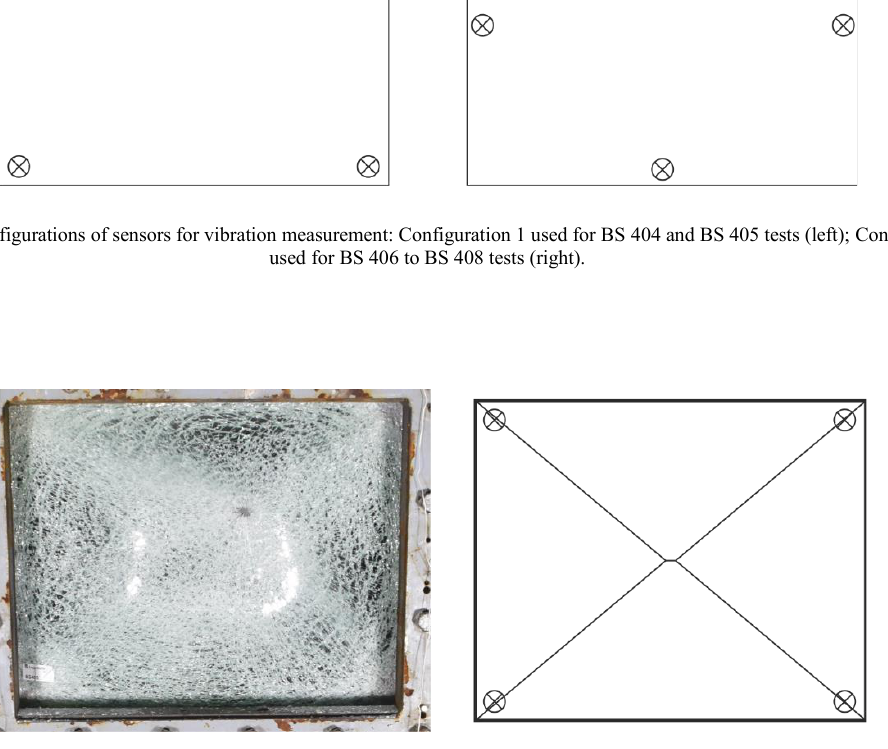
Fig. 3 Fracture pattern of glass pane 1 in BS 405 test (left); position sensors in relation to theoretical position of fracture lines